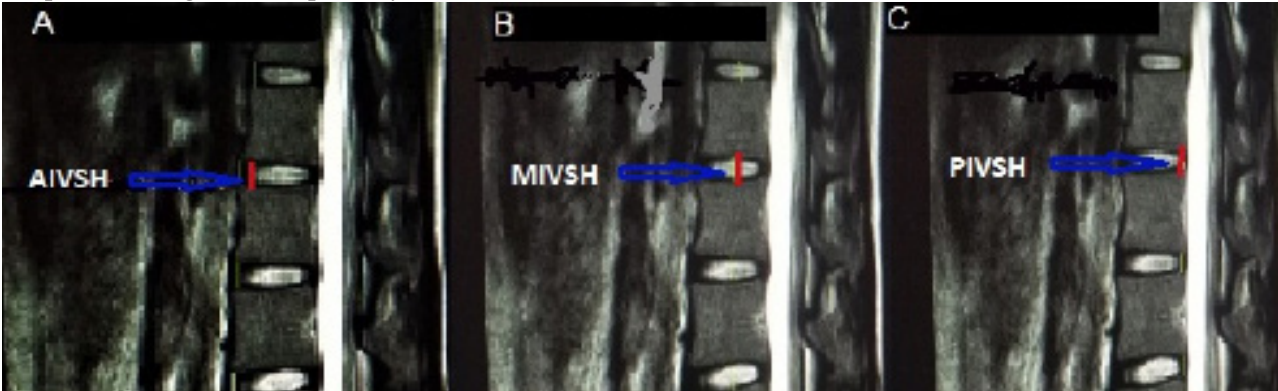
Fig. 1. Blue arrow marks showing intervertebral space heights- A; AIVSH (anterior intervertebral space height–red line), B; MIVSH (middle intervertebral space height–red line) and C; PIVSH (posterior intervertebral space height–red